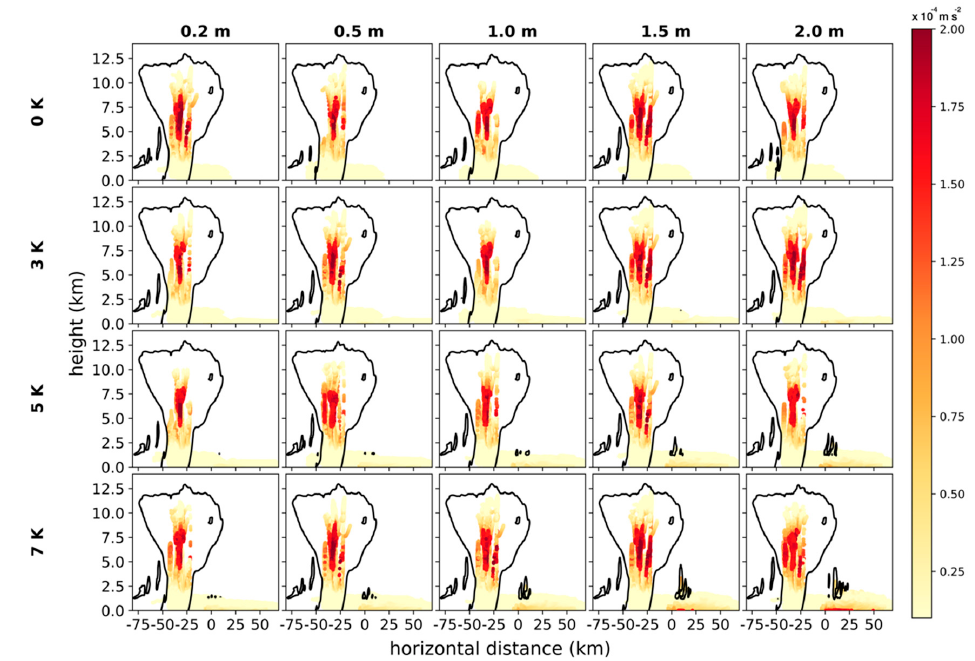
Figure 10. Time-space evolution of forward-integrated parcel trajectories that are located in the updraft at t = 120 min. The position of each parcel over the previous 50 min is shown, with a temporal resolution of 1 min. At each location, the parcel’s location marker is colored by B. The black line is the 0.02 g kg − 1 contour hydrometeor mixing ratio at t = 120 min.